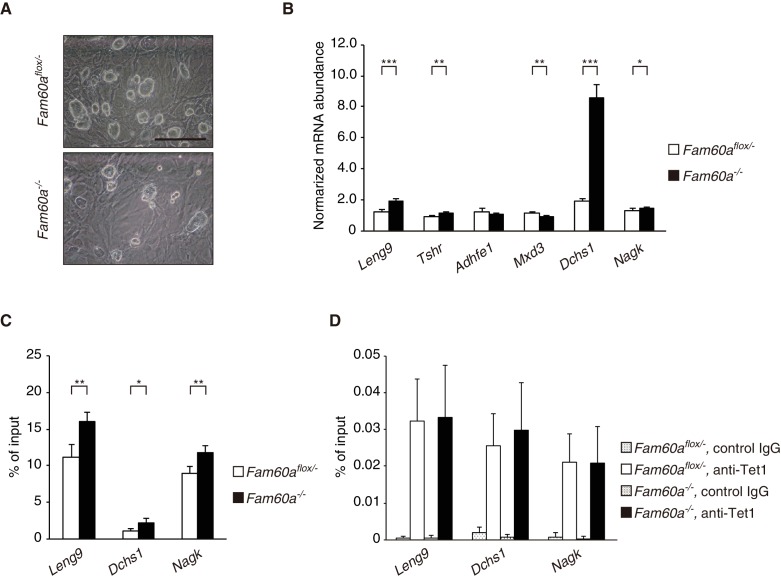
Expression profile as well as AcH3K9 deposition and Tet1 recruitment at promoter regions of Fam60a target genes in mouse ES cells.(A) Phase-contrast microscopy showing the morphology of Fam60aflox/– and Fam60a–/– ES cells. Scale bar, 100 µm. (B) RT-qPCR analysis of mRNAs for the indicated Fam60a target genes in Fam60aflox/– and Fam60a–/– ES cells. Data are means ± s.d. for five independent experiments. *p<0.05, **p<0.01, ***p<0.001 (Student’s unpaired t test). (C) ChIP-qPCR analysis of AcH3K9 at the promoter region of the indicated Fam60a target genes in Fam60aflox/– and Fam60a–/– ES cells. Data are expressed as percentage of input and are means ± s.d. for four independent experiments. *p<0.05, **p<0.01 (Student’s unpaired t test). (D) ChIP-qPCR analysis of Tet1 recruitment to the promoter region of the indicated Fam60a target genes in Fam60aflox/– and Fam60a–/– ES cells. Immunoprecipitation was performed with antibodies to Tet1 or with control IgG. Data are means ± s.d. for three independent experiments.